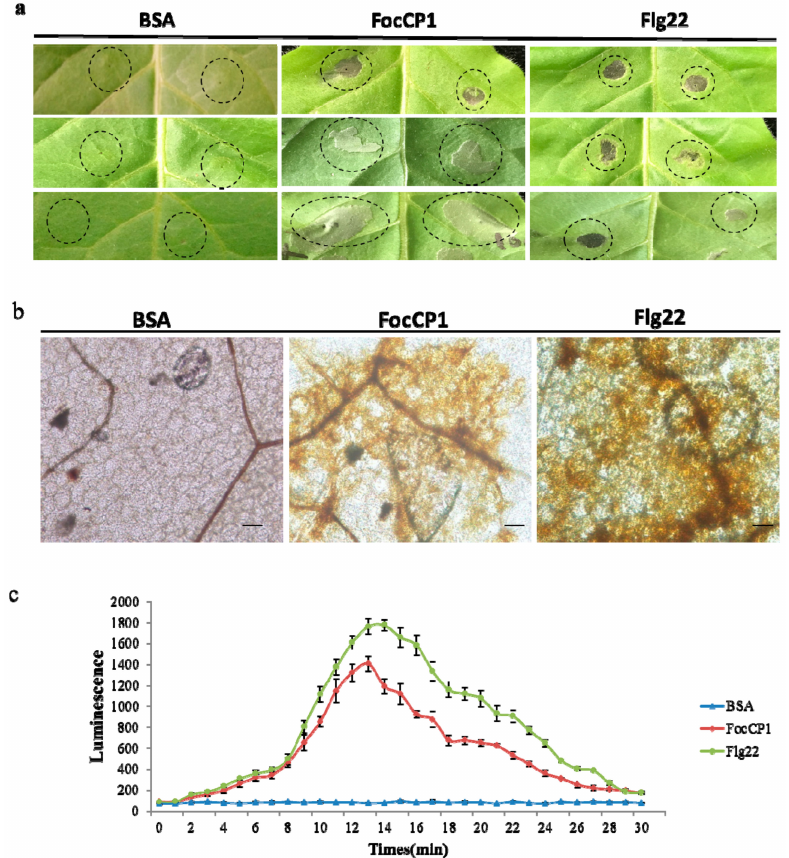
Figure 3. FocCP1 caused hypersensitive response (HR) and reactive oxygen species (ROS) accumulation in tobacco. ( a ) HR was measured in tobacco leaves infiltrated with FocCP1 protein. Six leaves of three plants were used for each replication. ( b ) ROS accumulation was observed in tobacco leaves infiltrated with FocCP1 under microscopy, Flg22 induced obvious H 2 O 2 accumulation, but bovine serum albumin (BSA) did not. Scale bar = 50 µ m. ( c ) ROS burst was detected in tobacco cell culture after FocCP1 treatment, ROS formation improved: better increased after 5 min and reached a maximum at approximately 12–14 min, and gradually lowered to the level of the negative control. In all experiments, flg22 and bovine serum albumin (BSA) were the positive and negative controls, respectively, and three independent replicates were performed. Values are means ± standard error